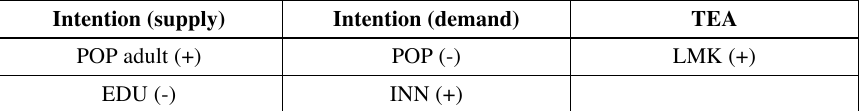
Table 4 The list of exogenous variables included in the model (the sign in parentheses denotes the impact “+” positive, “-” negative) Intention (supply) Intention (demand) TEA POP adult (+) POP (-) LMK (+) EDU (-) INN